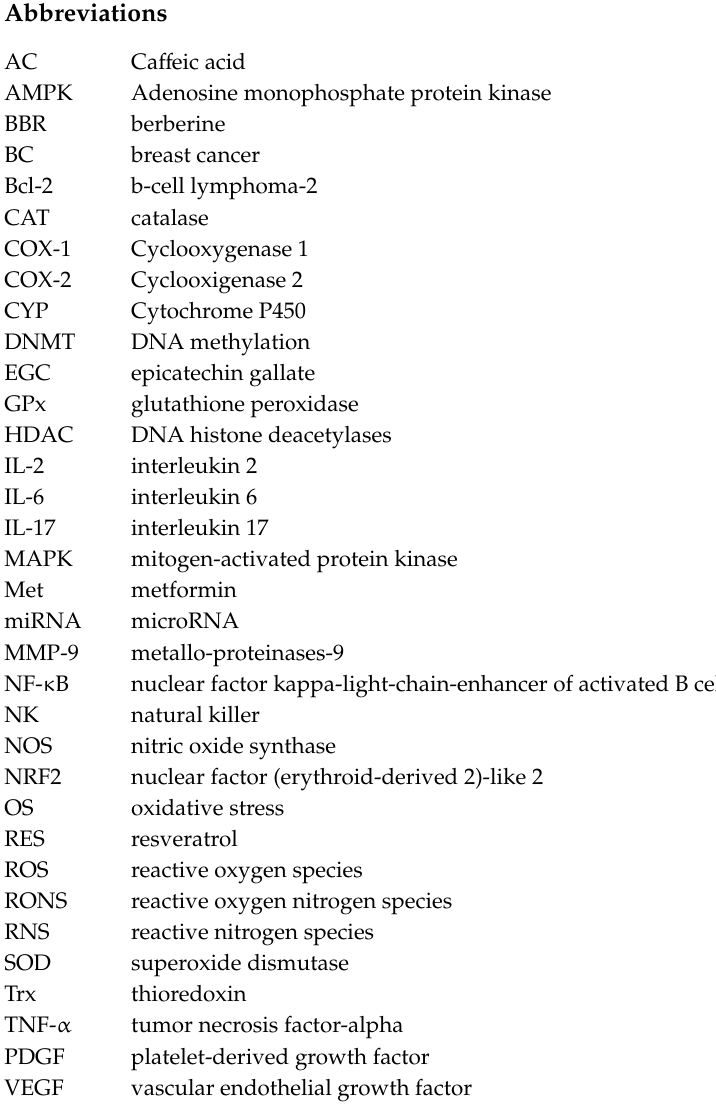
ff erent approaches in cancer prevention and chemotherapy Figure 4. Different approaches in cancer prevention and chemotherapy treatment. Figure 4. Di